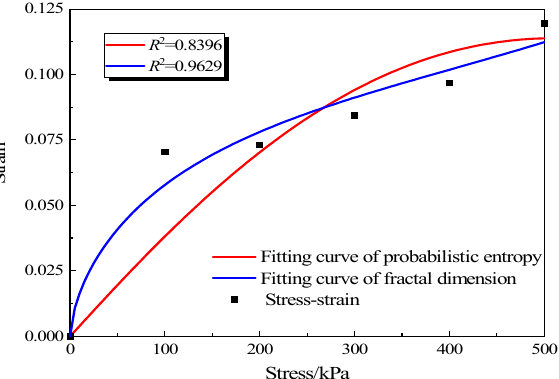
Figure 9. Fitting results by probability entropy and fractal dimension.